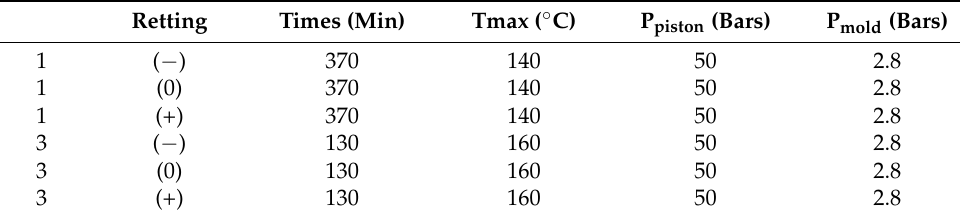
Table 1. Process parameters of the obtained biobased composite .